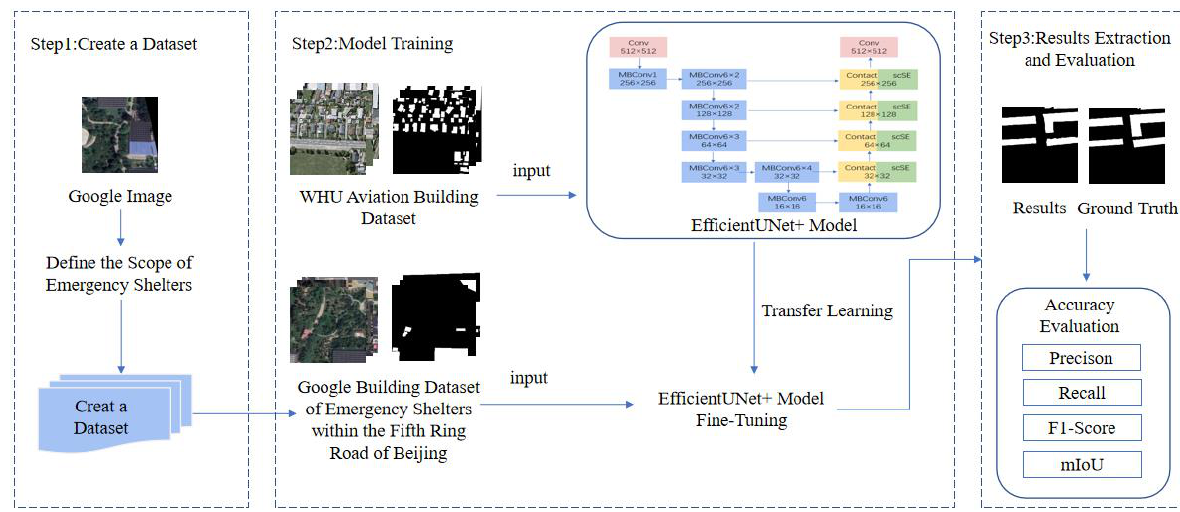
Figure 1. The technical route of this study.